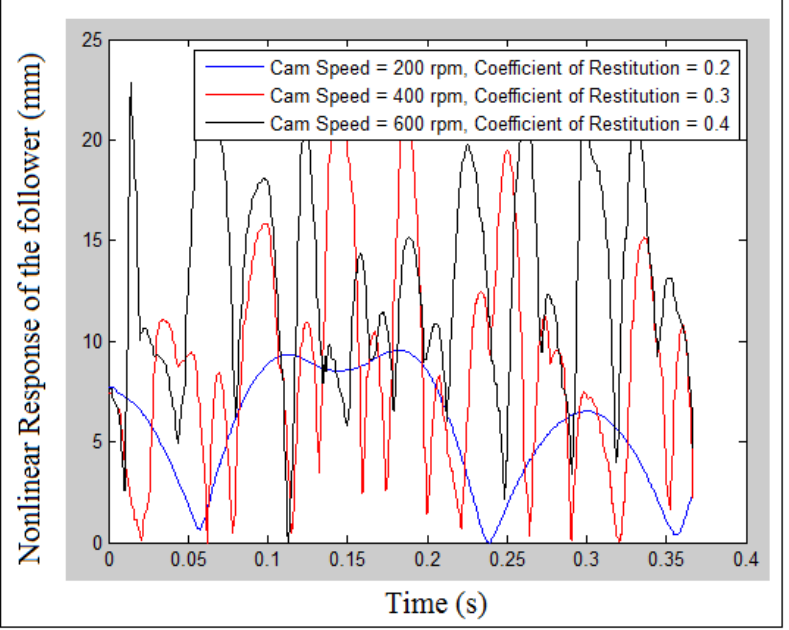
Figure 3. Nonlinear response when the follower offsets to the left at (O = 10 mm) at follower guide clearance (16 mm).